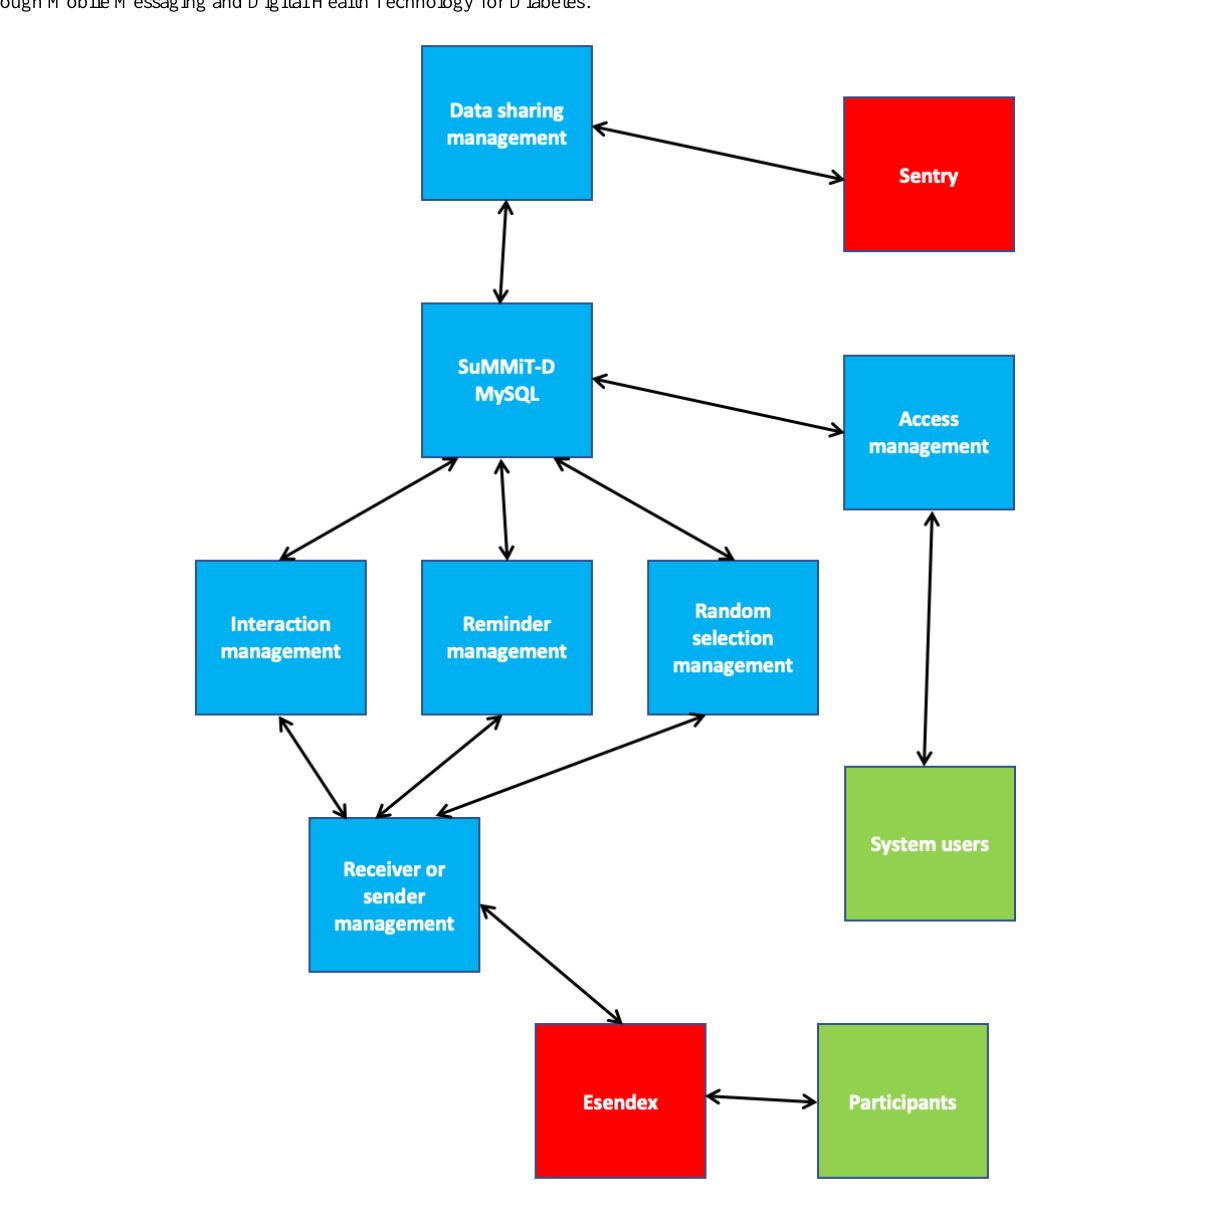
Figure 2. Support through Mobile Messaging and Digital Health Technology for Diabetes architecture. Sentry: Secure entry; SuMMiT-D: Support Through Mobile Messaging and Digital Health Technology for